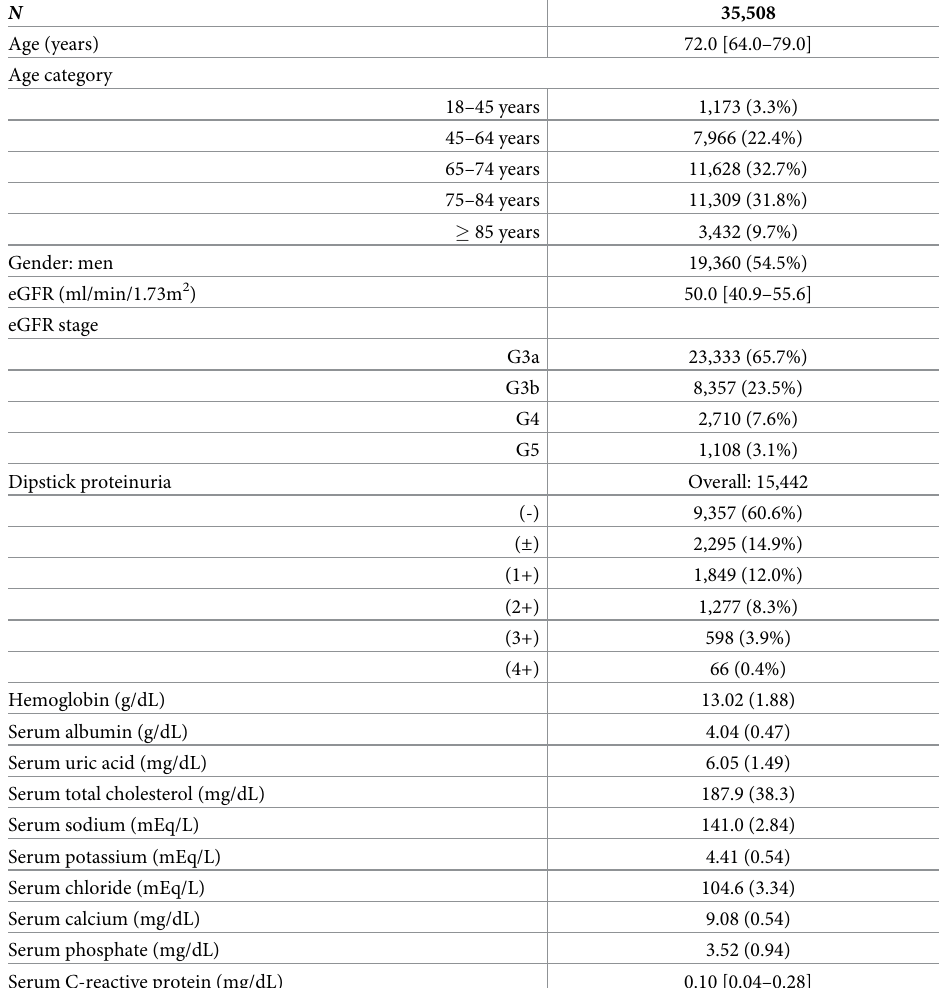
Table 2. General characteristics of study cohort upon